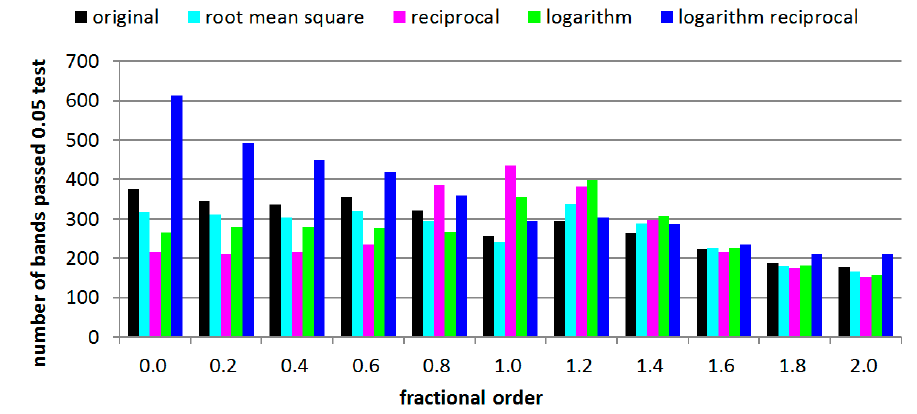
Figure 6. Number of bands that passed the 0.05 test